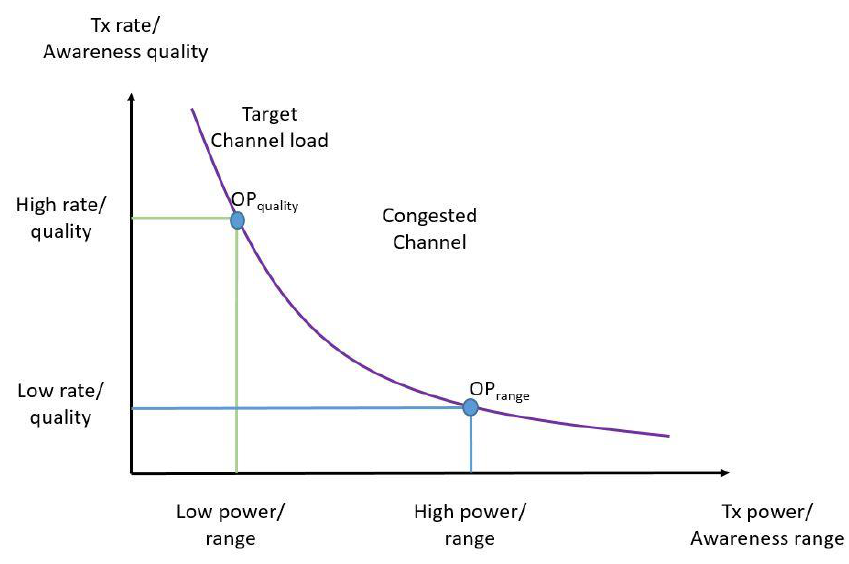
Figure 3. The trade-off dilemma by using constant transmit powers